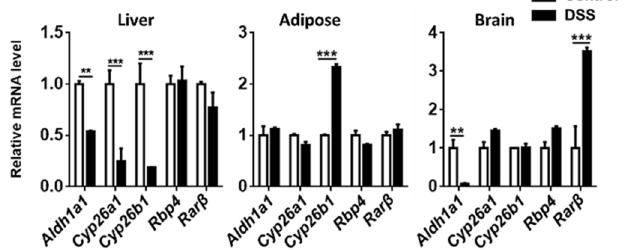
Figure 6. RA signaling gene expression in the liver, adipose, and brain of mice treated with or with- out DSS. Data are expressed as mean ± SD. n =9 per group. Student’s t-test. * p < 0.05, ** p < 0.01, *** p <